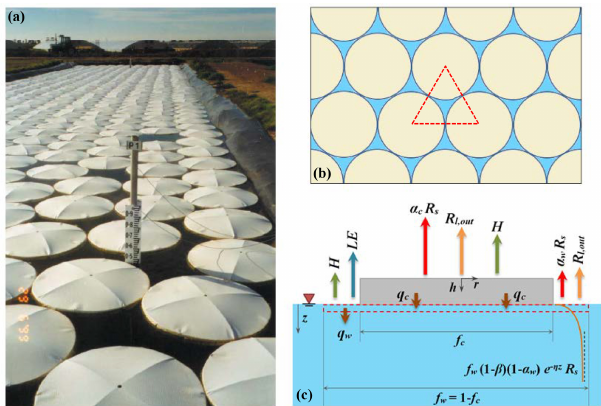
Figure 3. (a) Application of floating discs in evaporation suppres- sion from water reservoirs (adapted from Assouline et al., 2011); (b) top view of reservoir surface covered with discs; due to the geo- metrical constraints, dense packing of discs provides a surface cov- erage of 0.91 (inferred from the depicted triangle with side lengths equal to disc diameter); (c) schematic representation of subsurface radiation attenuation (the curve with associated expression) and sur- face heat fluxes in a representative unit cell including a floating el- ement and free water surrounding it with areal fractions of f c and f w , respectively (Eq. 12). See Sect. 2 for definition of the various